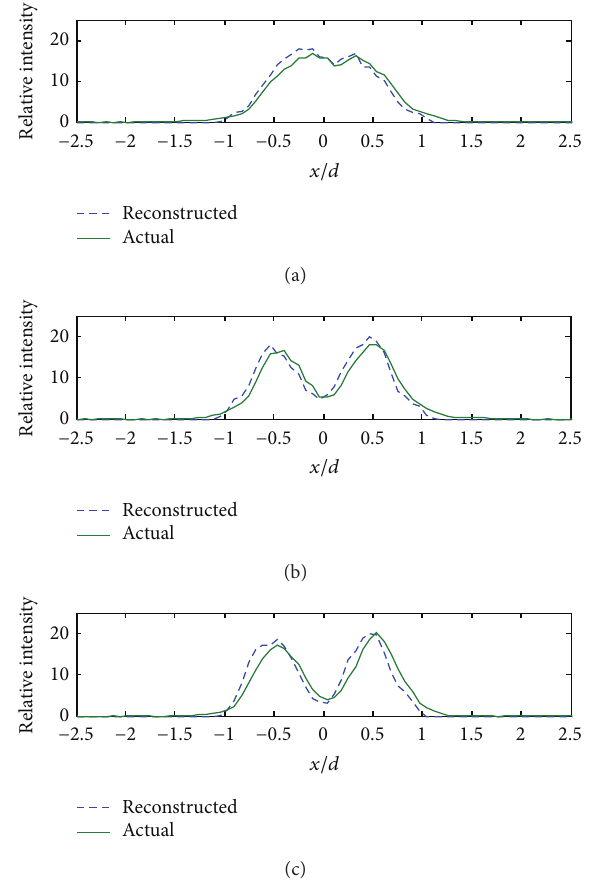
Figure 9: Comparison of relative intensity distributions of the reconstructed results and the side image at three different heights of 2,6,and10 mmfromthebottomtothetop(theaxis“ 𝑥/𝑑 ”represents the ratio of the distance to the center of the burner and the width of the